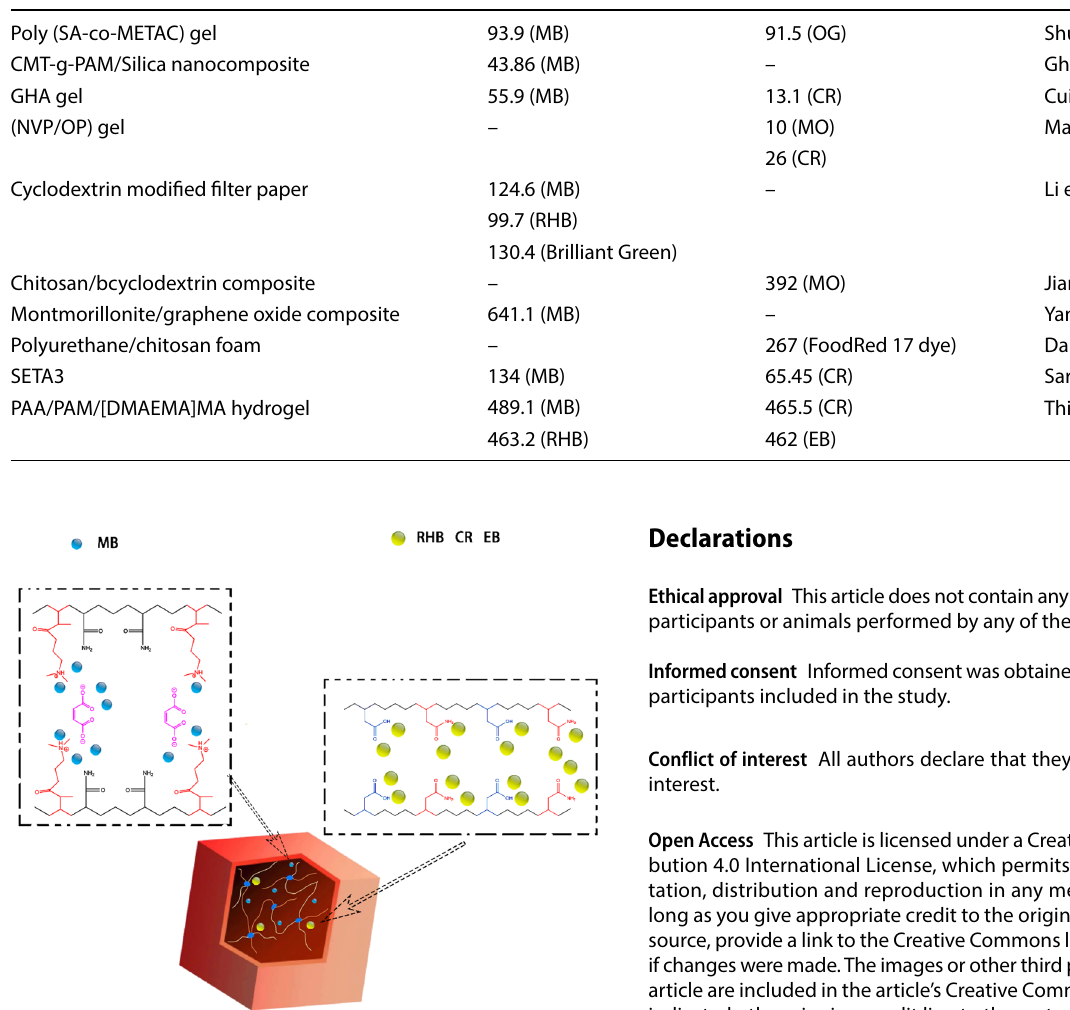
Table 3 Comparison of adsorption properties of dyes with other hydrogels Hydrogel